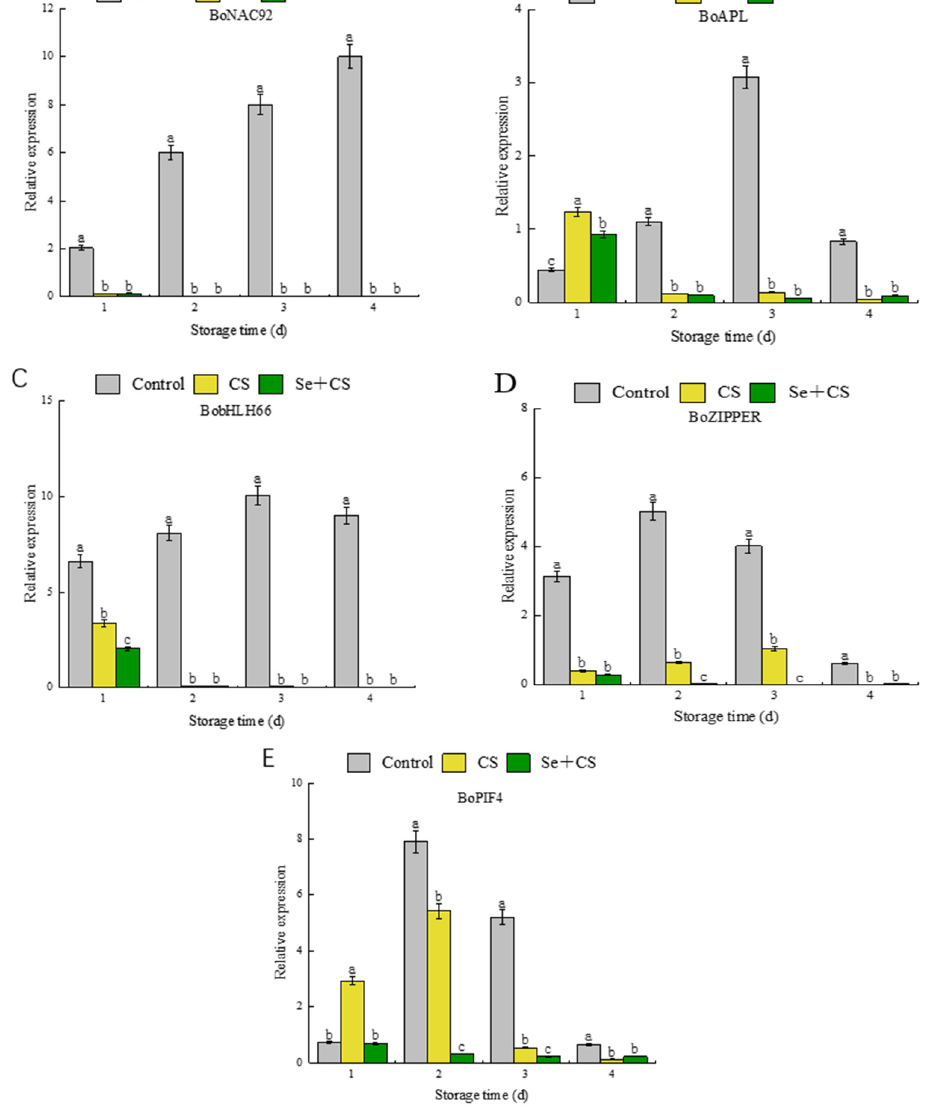
Figure 6. Relative gene expressions of pigment metabolism-related transcription factors in broccoli treated with Se+CS during storage. ( A ). BoNAC92 . ( B ). BoZIPPER . ( C ). BobHLH66 . ( D ). BoAPL . ( E ). BoPIF4 . Different letters represent significant differences in the same group during storage ( p < 0.05) by Duncan’s multiple range test.